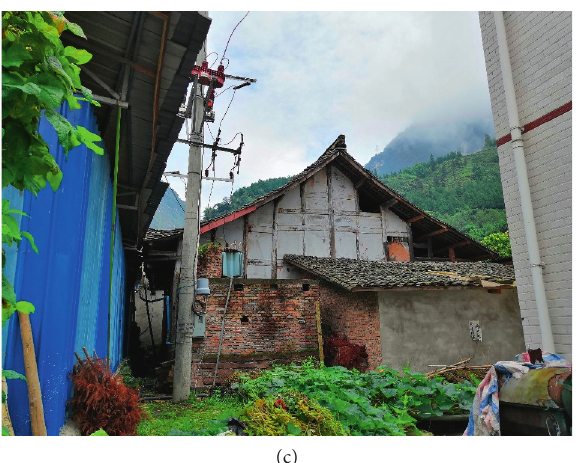
Figure 6: (a) Wooden construction. (b) Information extraction of wooden construction. (c) Wooden construction of